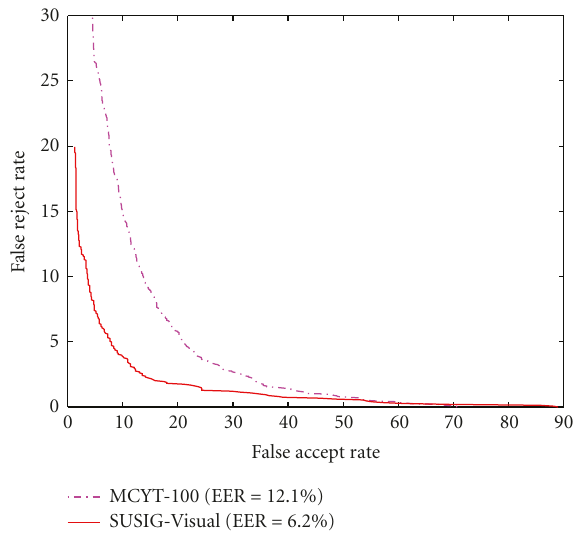
Figure 3: DET curves show how FAR ( x -axis) and FRR ( y -axis) values change according to changing acceptance threshold, for the tested